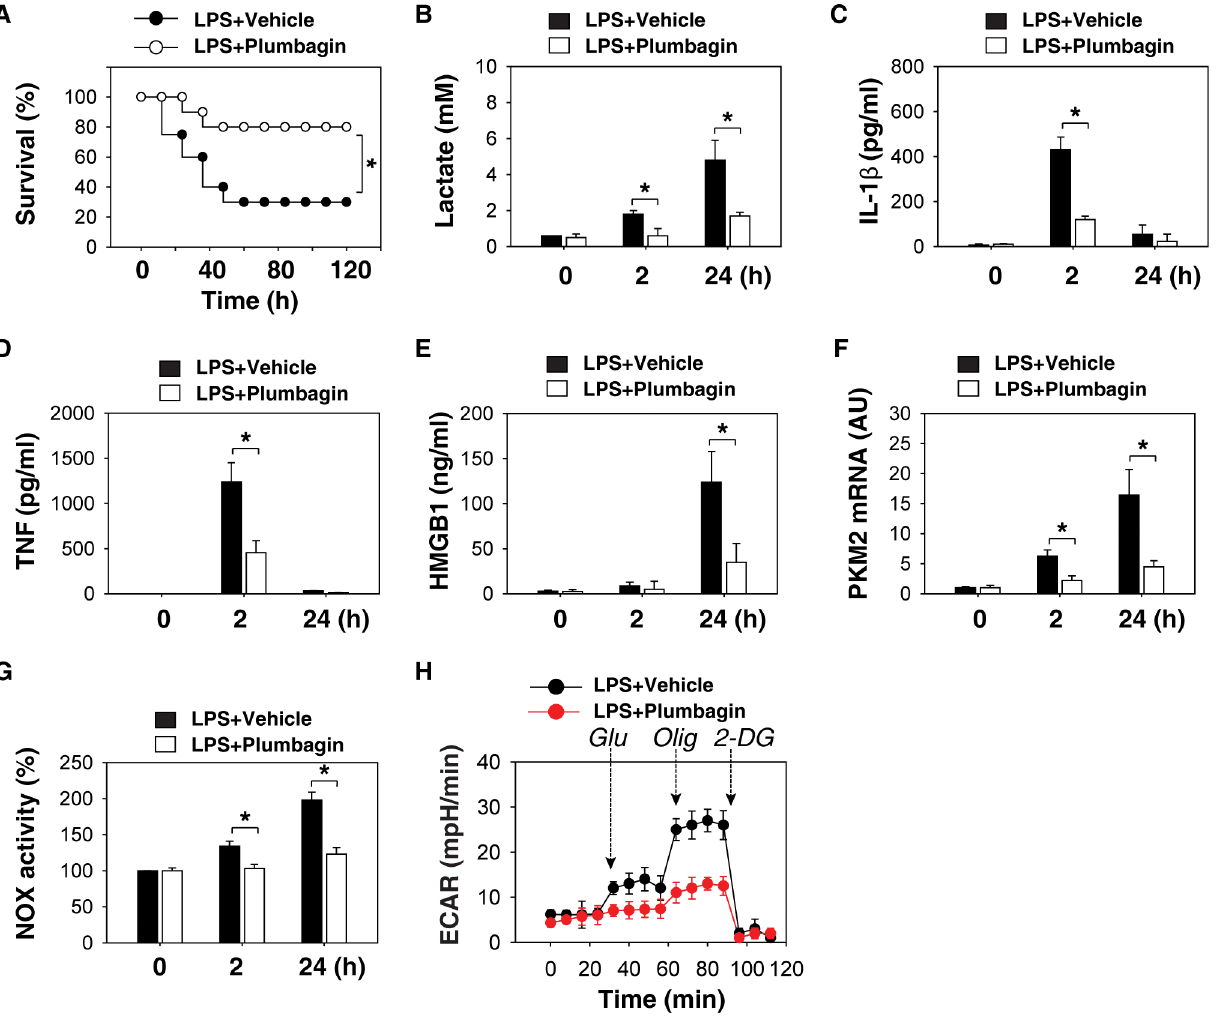
Figure 5. Plumbagin protects mice from endotoxic shock. (A) Mice (n = 20/group) were injected with a single dose of plumbagin (4 mg/kg), followed 30 min later by an infusion of endotoxin (lipopolysaccharide [LPS], 5 mg/kg, intraperitoneally), and were then re-treated with plumbagin 12 and 24 h later. The Kaplan-Meier method was used to compare the differences in survival rates between groups (*, p < 0.05). (B–H) In parallel experiments, serum levels of lactate (B), IL-1 β (C), TNF (D), HMGB1 (E), PKM2 mRNA (F), NOX activity (G) and ECAR (H) in isolated peritoneal macrophages at indicated time points were measured (n = 3–5 animals/group, values are mean ± SEM, *, p <